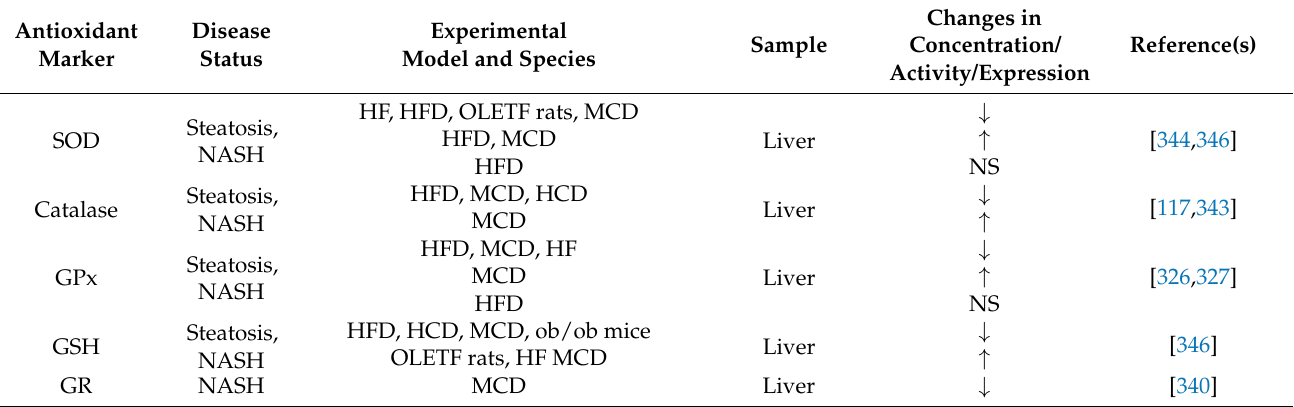
Table 3. Antioxidant markers in animal models of